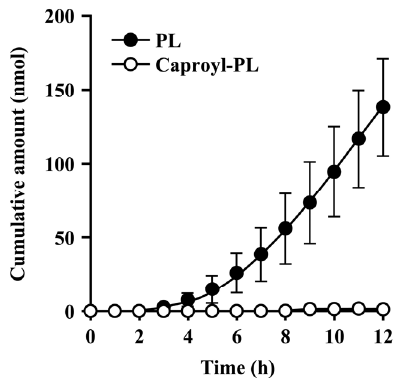
Figure 5. Permeation profile of caproyl-PL and PL across rat full-thickness skin after application of caproyl-PL. Open and closed symbols show caproyl-PL and PL transported into the receiver side, respectively. Each value represents the mean ± S.D. ( n = 6).